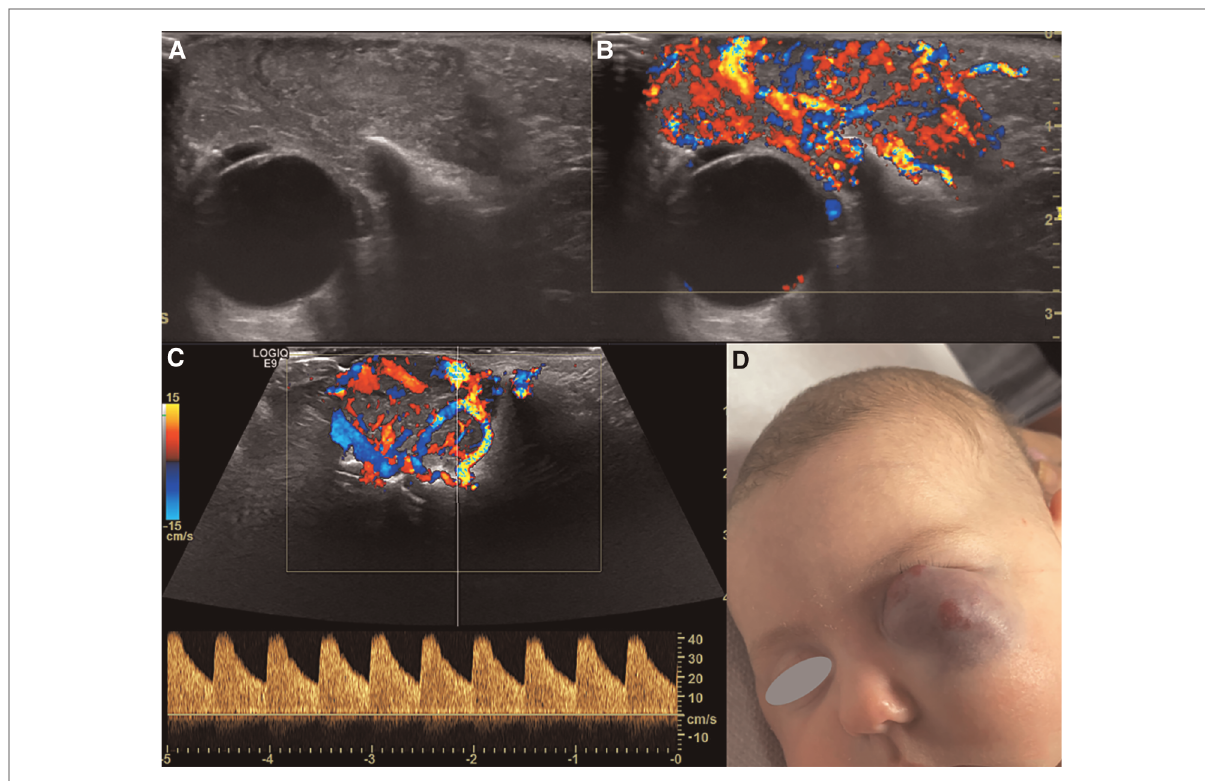
FIGURE 2 Us of an infantile hemangioma (IH) of the left orbit in a 5-month-old boy, during the proliferative phase. B-mode US shows a hyperechoic mass with well-de fi ned margins overlying the globe ( A ) and a very high vascular density at Color-Doppler US ( B ). Spectral analysis revealed the presence of low resistance arterial fl ow ( C ). The clinical appearance of the lesion is depicted in ( D